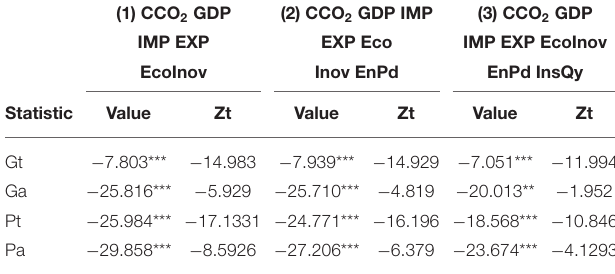
TABLE 5 | Panel cointegration